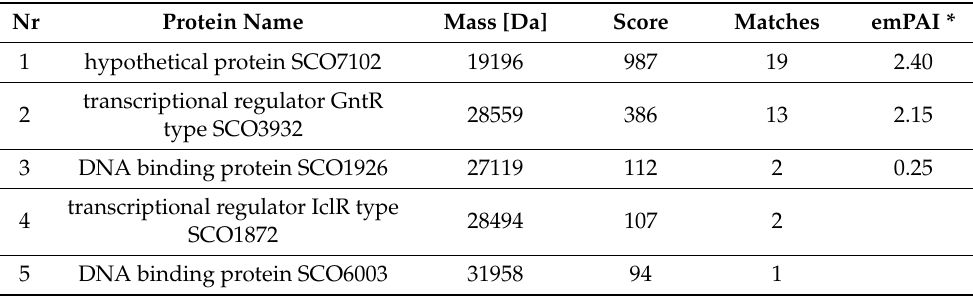
Table 1. S. coelicolor A3(2) regulatory proteins interacting with bait fragments, detected by mass spectrometry.